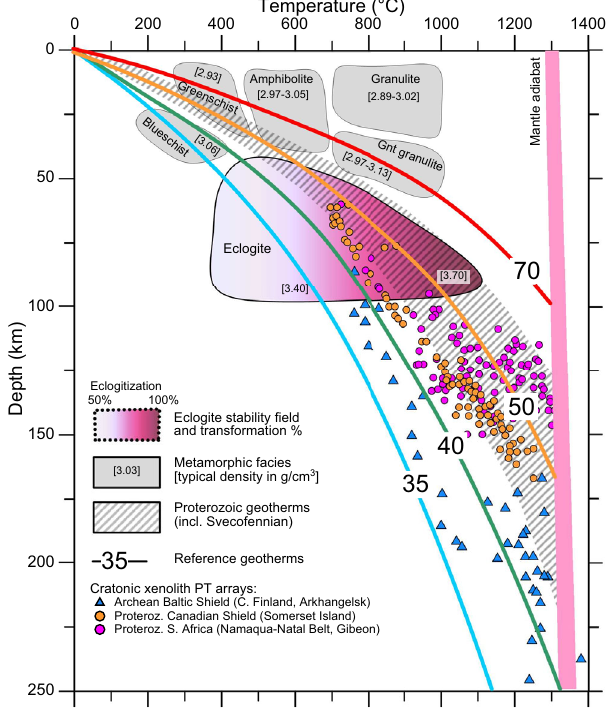
Fig. 5 Continental geotherms based on heat fl ow 70 . Labels at colour lines — surface heat fl ow. Hatched region — geotherms in the Svecofennian province. Colour symbols — xenolith P – T arrays (c.f. 70 ) from Archaean terranes of Fennoscandia (triangles) and Proterozoic terranes of the Canadian Shield and the Kalahari craton (circles); no xenolith P – T arrays are available for the Svecofennian province. Grey shading — metamorphic facies pertinent to eclogite formation 15 ; pink shading — degree of eclogitization 15 . Numbers in brackets — typical density contrast (0.2 – 0.3 g/cm 3 ) between mantle peridotites and